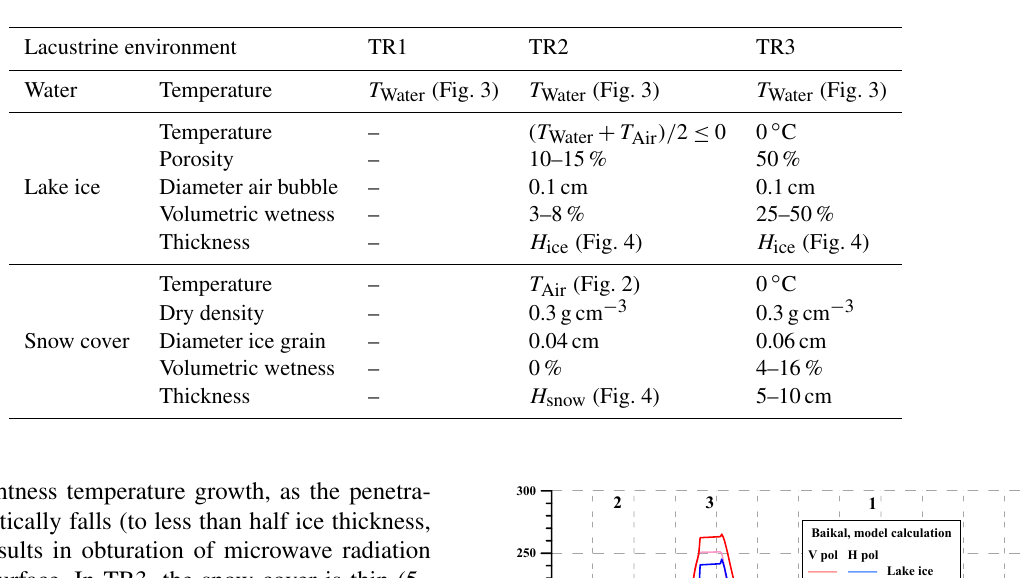
Table 3. Properties of snow cover, lake ice and water taken for brightness temperature modeling in TR1, TR2 and TR3. Standard deviations of ice grain and air bubble sizes were assumed at 40%.